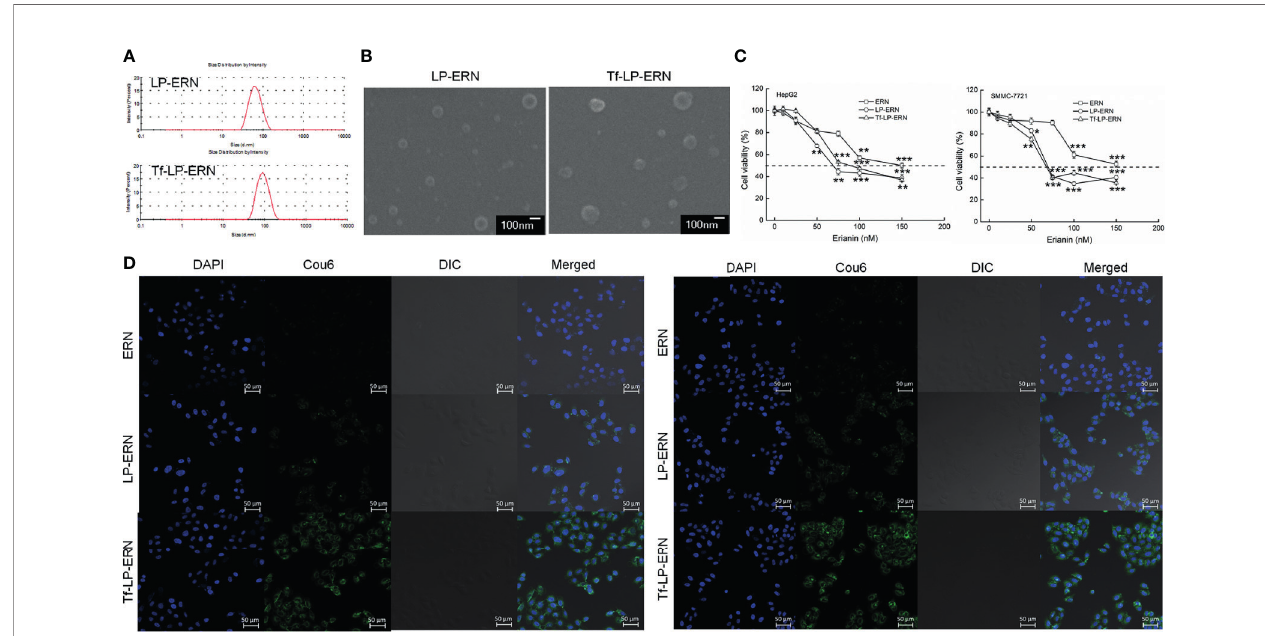
FIGURE 1 | Characterization of LP-ERN and Tf-LP-ERN. (A) The particle size distribution of LP-ERN and Tf-LP-ERN were uniform, both less than 100 nm (n = 3). (B) Field emission scanning electron microscopy (FESEM) images of LP-ERN and Tf-LP-ERN indicating their uniformly spherical (30,000 ×) (Scale bar: 100 nm) (n = 3). (C) ERN, LP-ERN and Tf-LP-ERN reduced the viability of HepG2 and SMMC-7721 cells in a concentration gradient (n = 6). (D) ERN, LP-ERN and Tf-LP- ERN can be taken up by HepG2 and SMMC-7721 cells (magni fi cation: 200, scale bar: 50 m m) (n = 3). Liposomes were labelled with Coumarin 6 (Cou6) and the nuclei were labelled with 4 ’ ,6-diamidino-2-phenylindole (DAPI). * P < 0.05, ** P < 0.01 and *** P < 0.001 vs . control